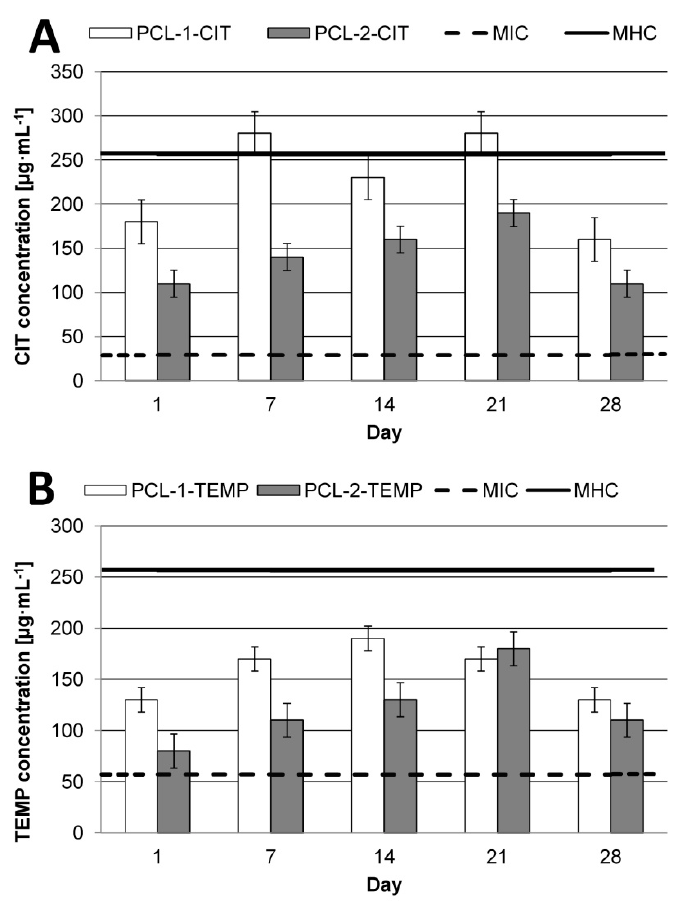
Figure 5. Peptide daily concentration after 1, 7, 14, 21, and 28 days of incubation in PBS solution at 37 °C and pH 7.4: ( A ) CIT; ( B ) TEMP. Geometric values of minimal inhibitory concentration (MIC) and minimal hemolytic concentration (MHC) were taken from the literature [13,31].